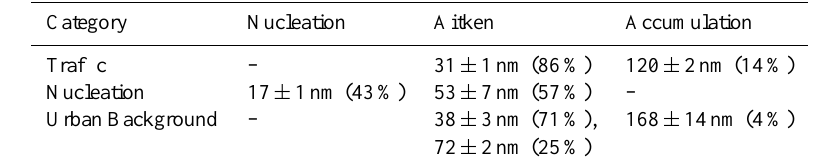
Table 4. k -means cluster categories average size distribution size mode peaks and corresponding area percentage. Only the main cities BCN, MAD and BNE were considered. Note the two Aitken modes for Urban Background.